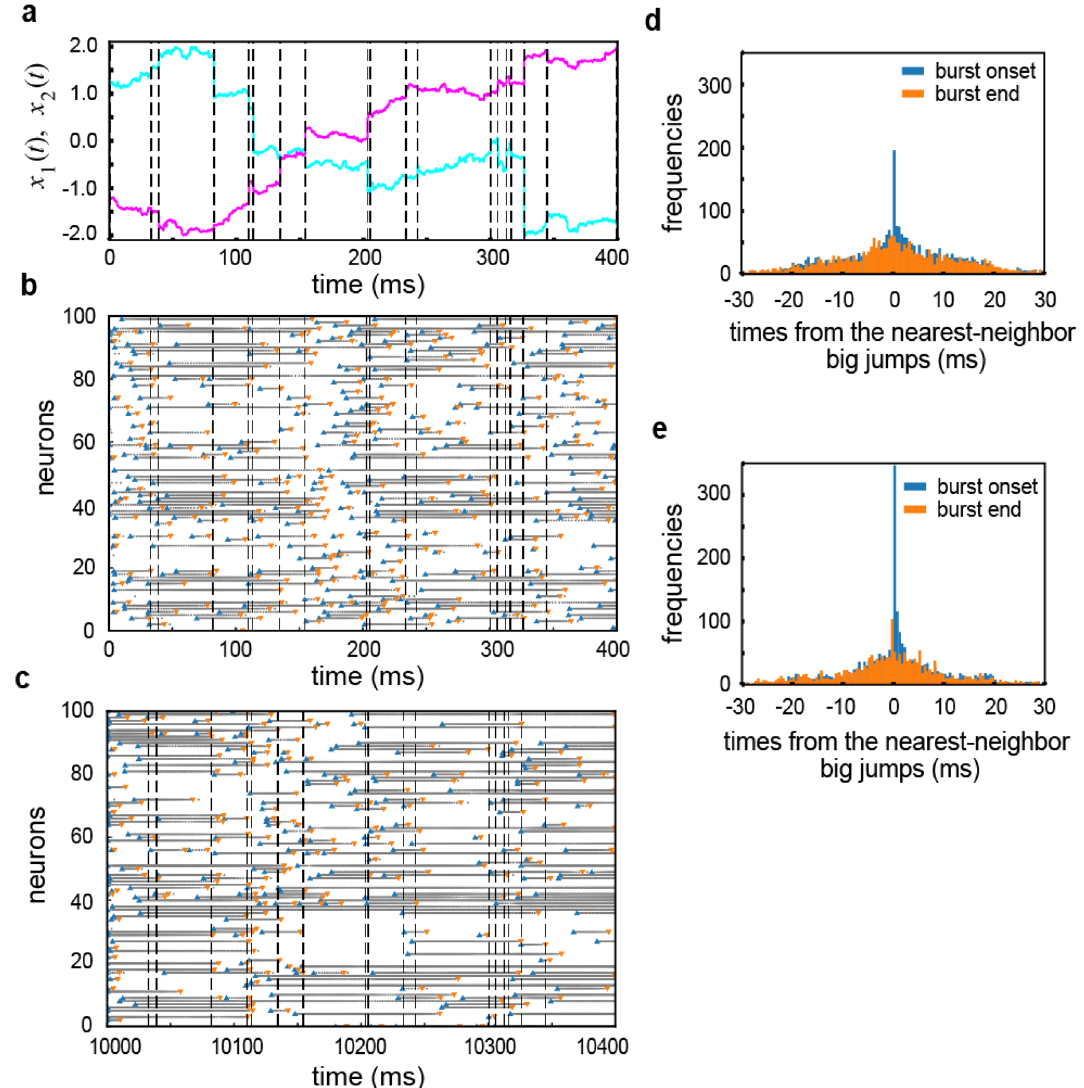
Figure 3. Temporal coordination of bursts by learning. ( a ) A two-dimensional target trajectory shows big jumps at the times indicated by vertical dashed lines. ( b ) Spike raster of 100 neurons sampled randomly from the reservoir before learning. ( c ) Spike raster is shown for the same neurons after learning. ( d , e ) Distributions of the onset and end times of bursts around the times of big jumps are calculated before ( d ) and after ( e )